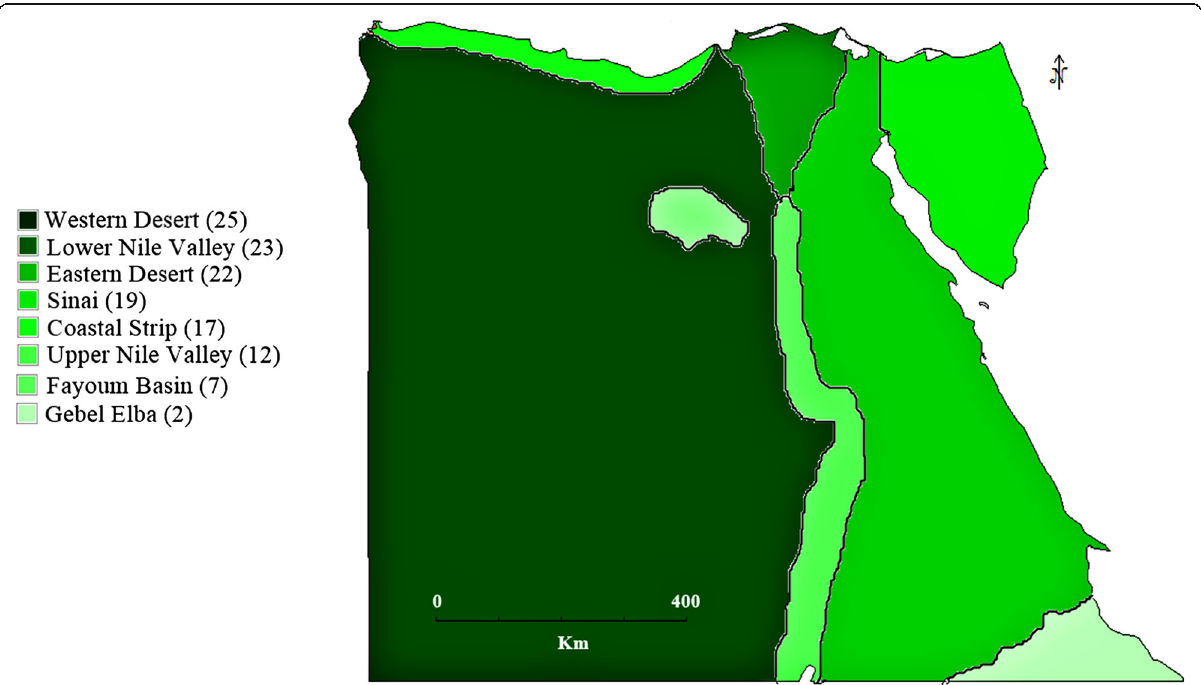
Fig. 1 Map of Egypt showing the eight ecological zones and the total number of Mantodea species collected from each zone